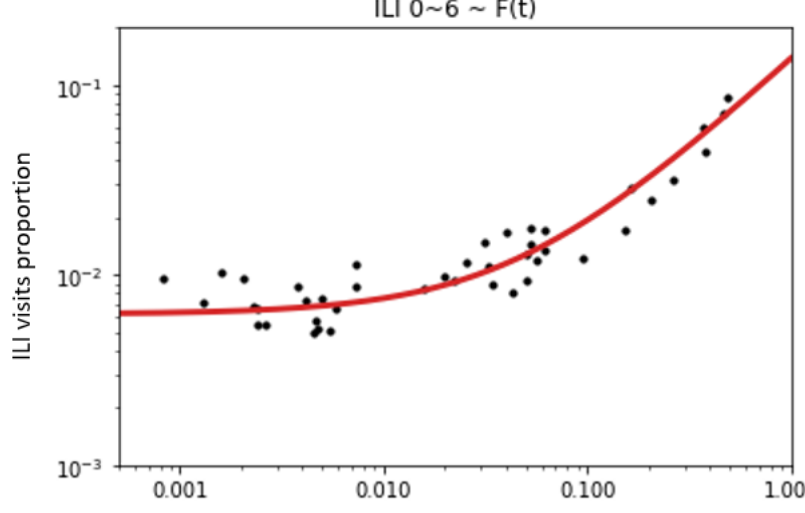
Figure 3. A log-scaled plot. Linear regression between F(t) and influenza-like illness (ILI) visit proportion of children younger than 7 years during the development period. Black dots show actual values, and red line shows the result of linear